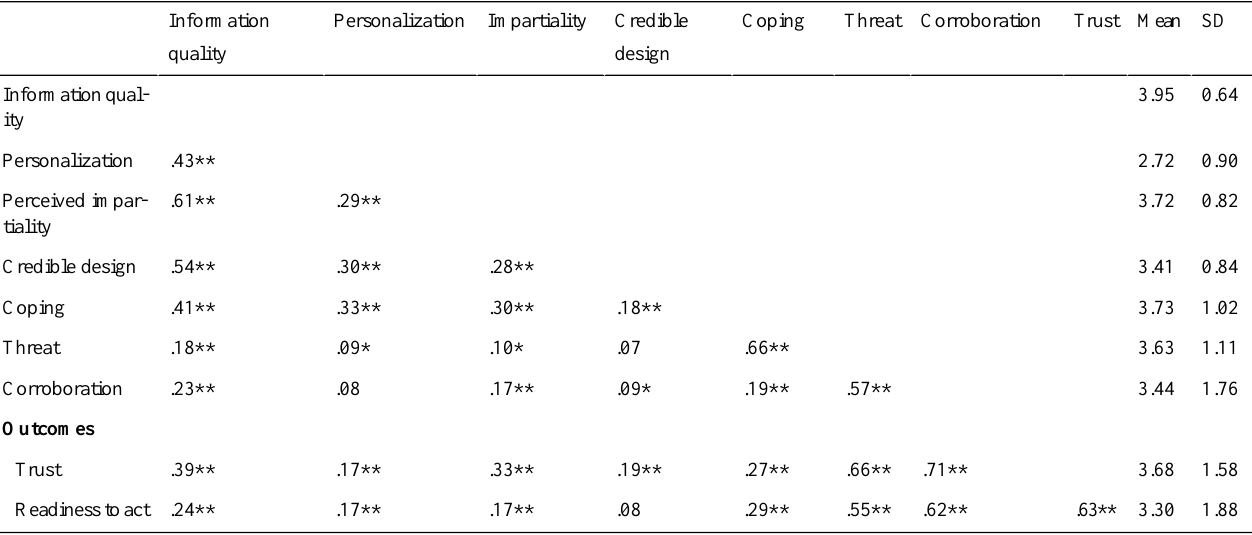
Table 3. Descriptive statistics and zero-order correlations between the measures